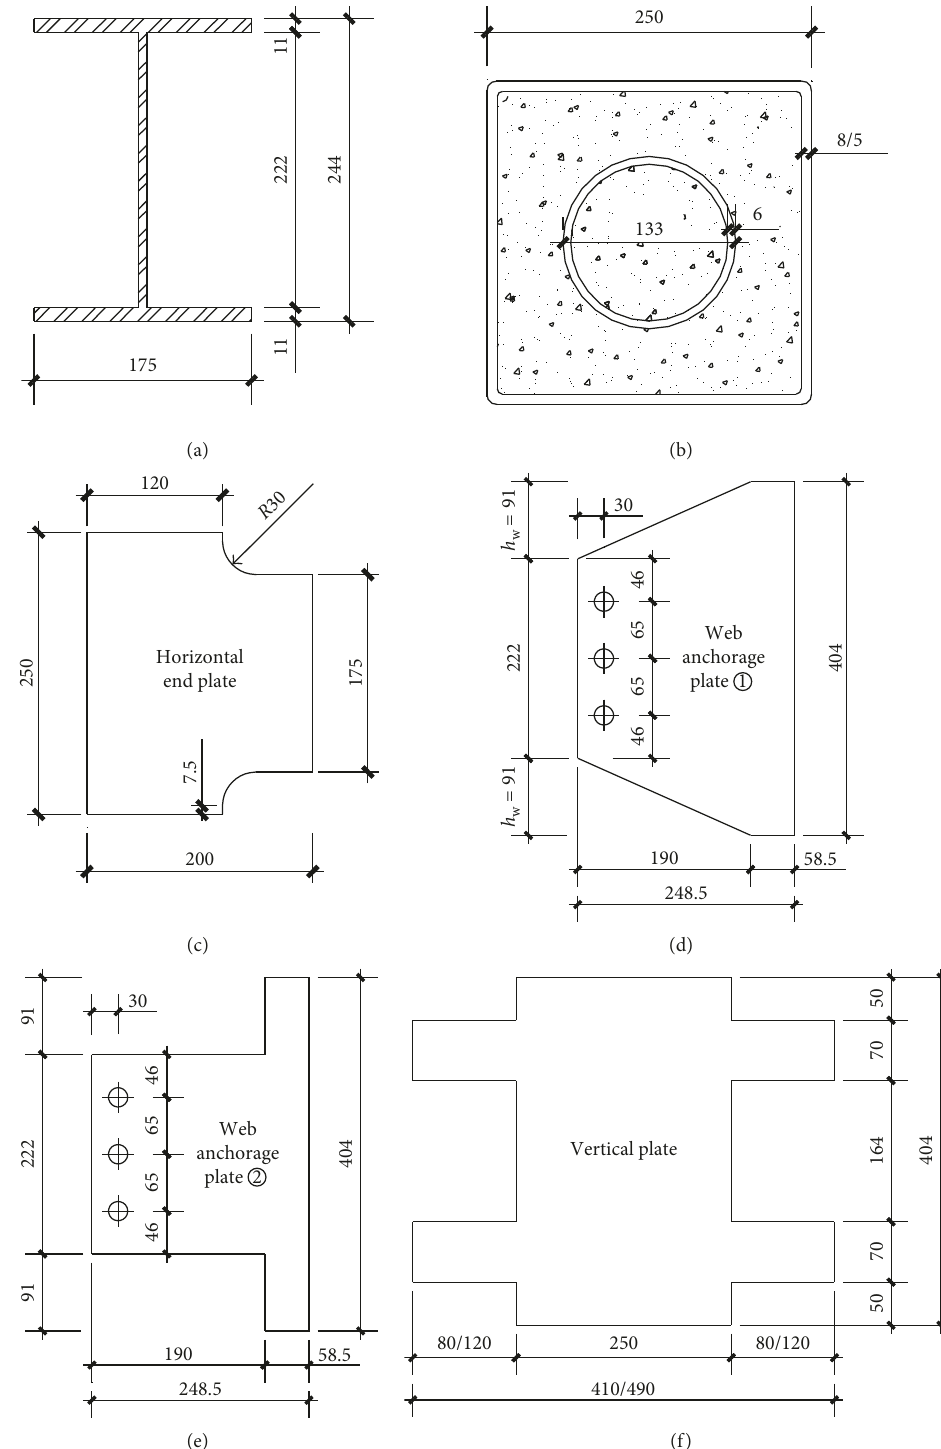
Figure 3: Details of the beam, column, and construction plates. (a) Beam. (b) Column. (c) Horizontal end plate. (d) Stiffening type. (e) Nonstiffening type. (f) Vertical